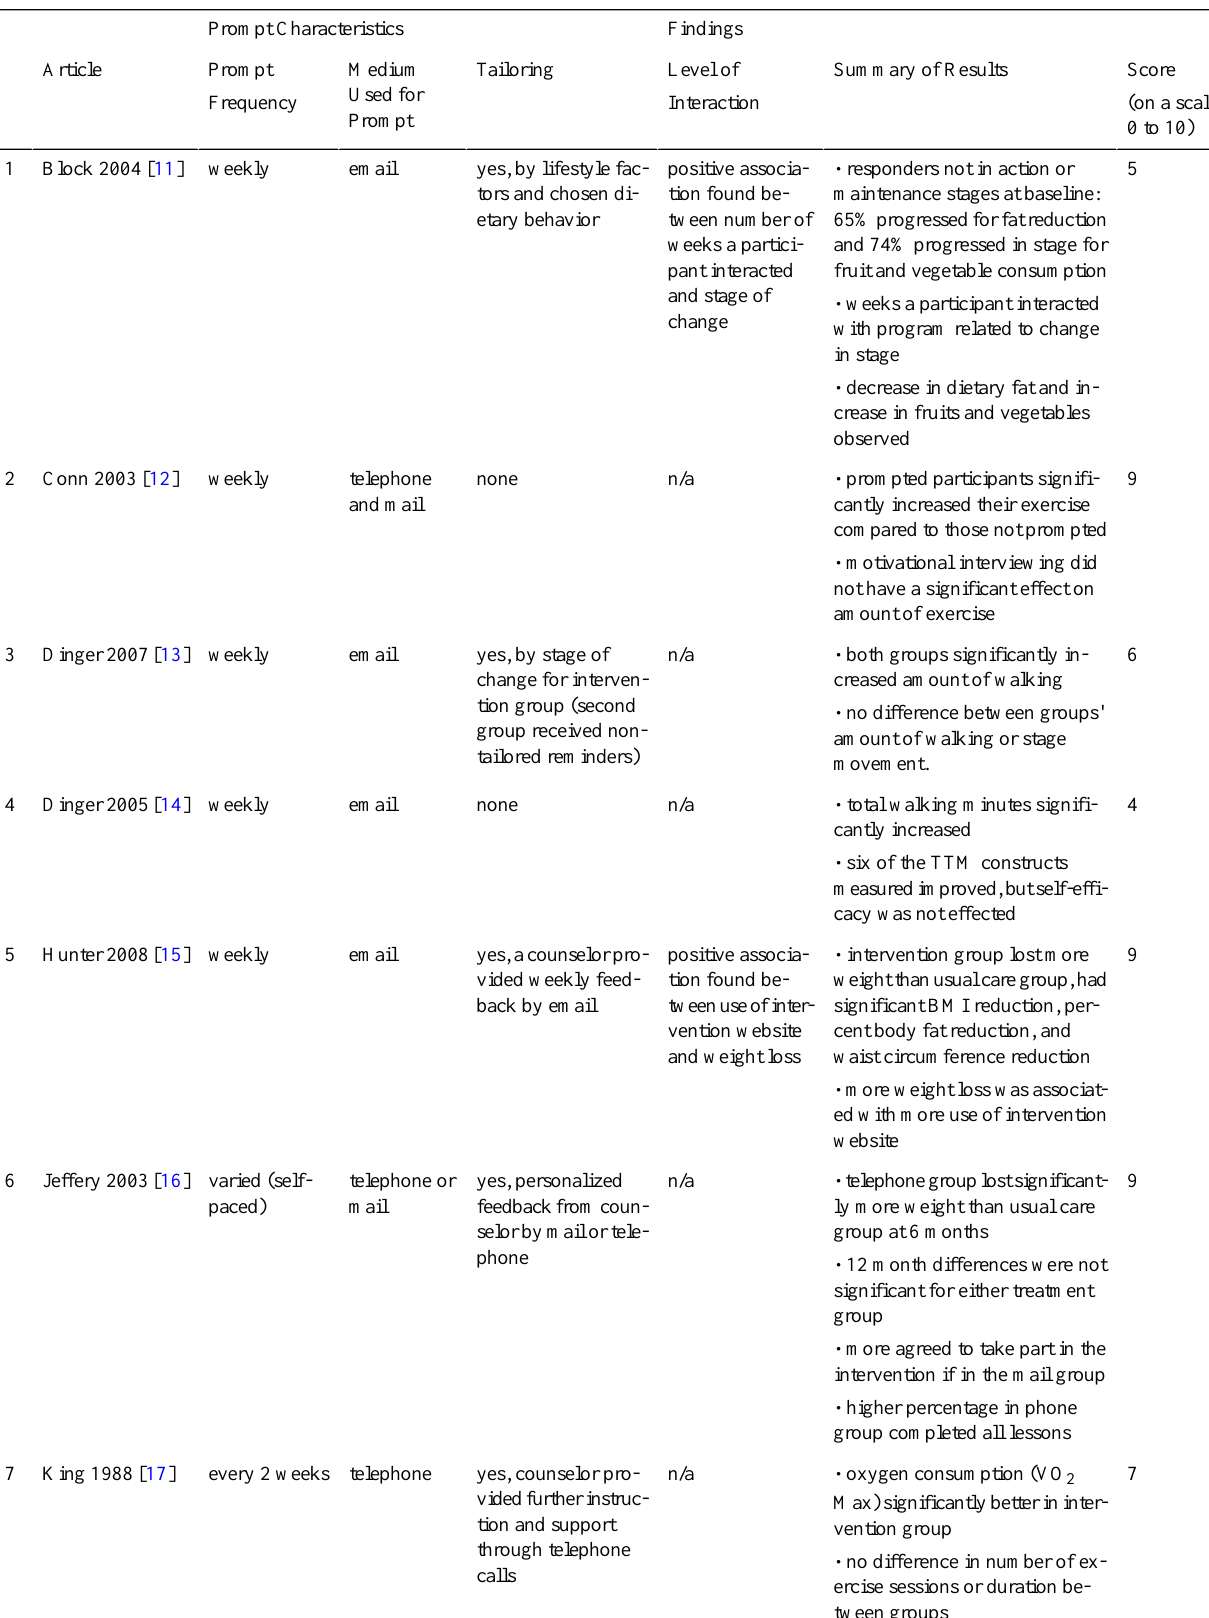
Table 3. Prompt characteristics, research questions, and